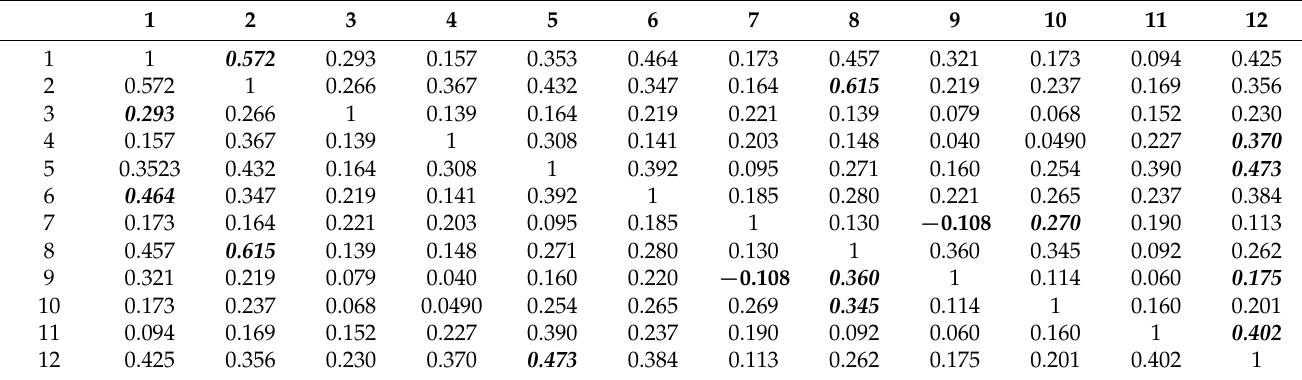
Table 2. Pearson correlation coefficient matrix of port freight